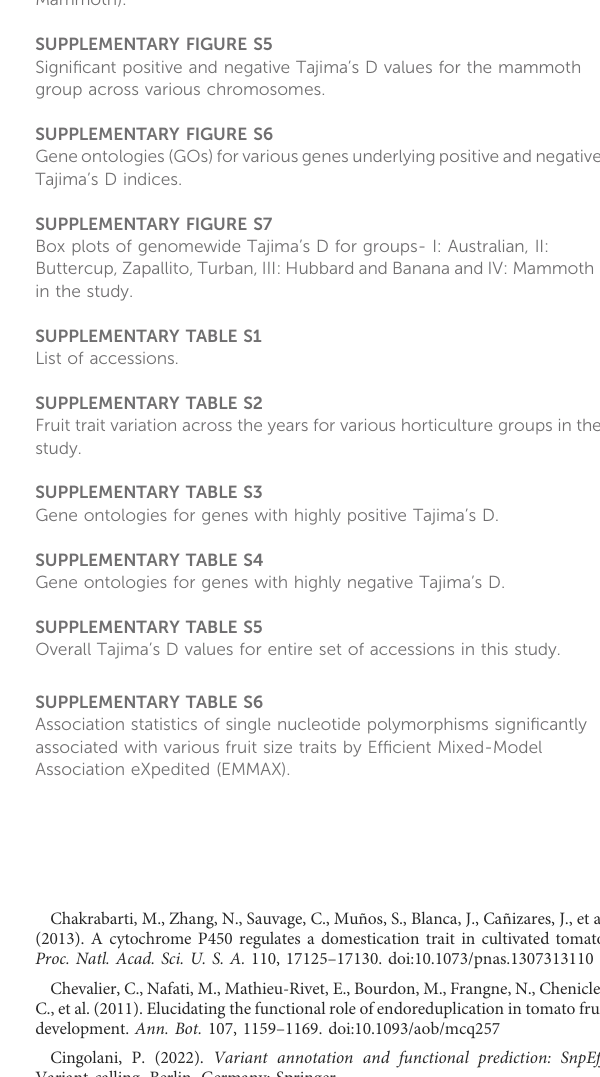
SUPPLEMENTARY FIGURE S1 Fruits of various horticulture groups: 1. Australian 2. mammoth 3.